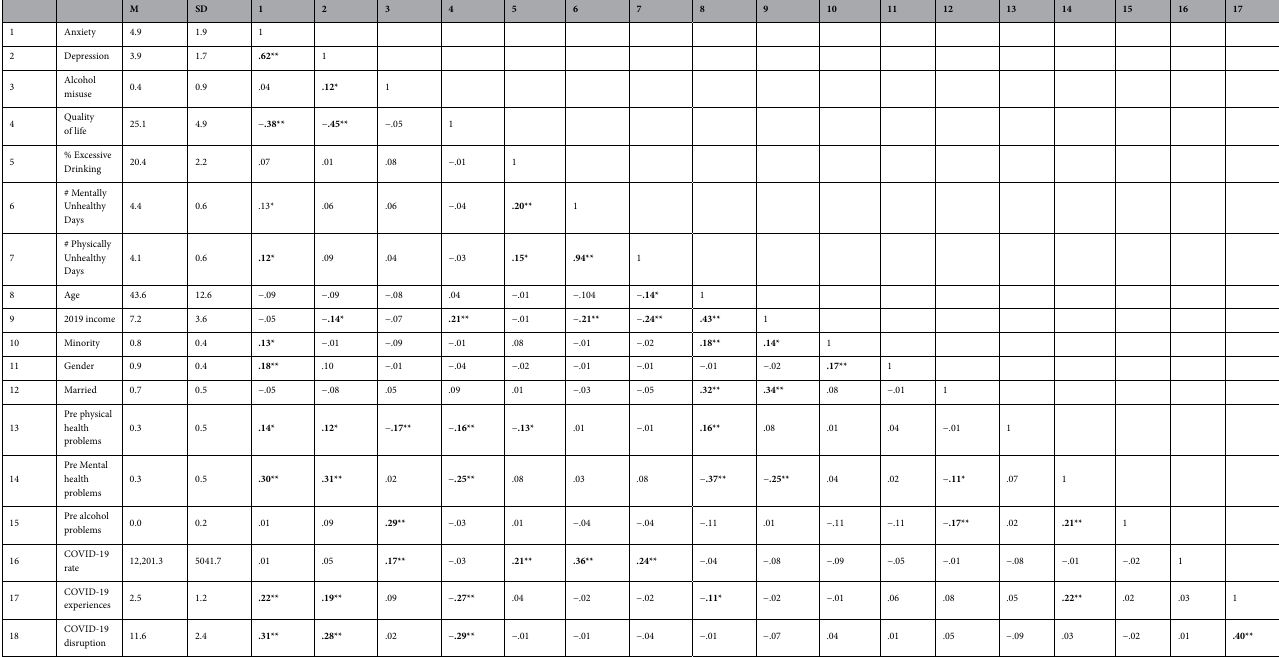
Table 2. Zero Order Coefficients and Descriptive Statistics. Significant values are in bold. * p < .05, ** p <